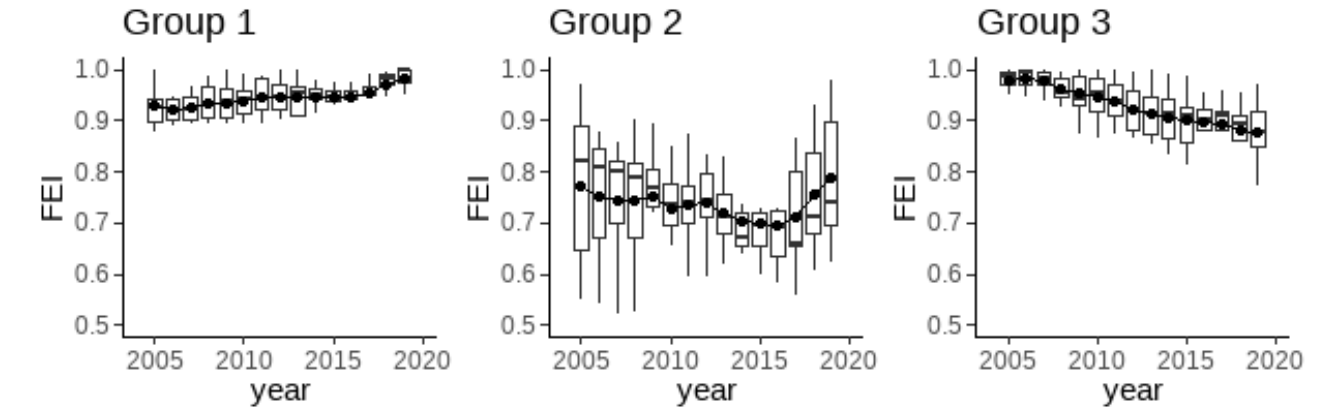
Figure 4. Changes in fertilizer use efficiency for regions with different food production responsibil- ities. Group 1, 2 and 3 represent the main grain-producing, main grain-marketing, and grain-pro- ducing-and-marketing-balanced areas, respectively.